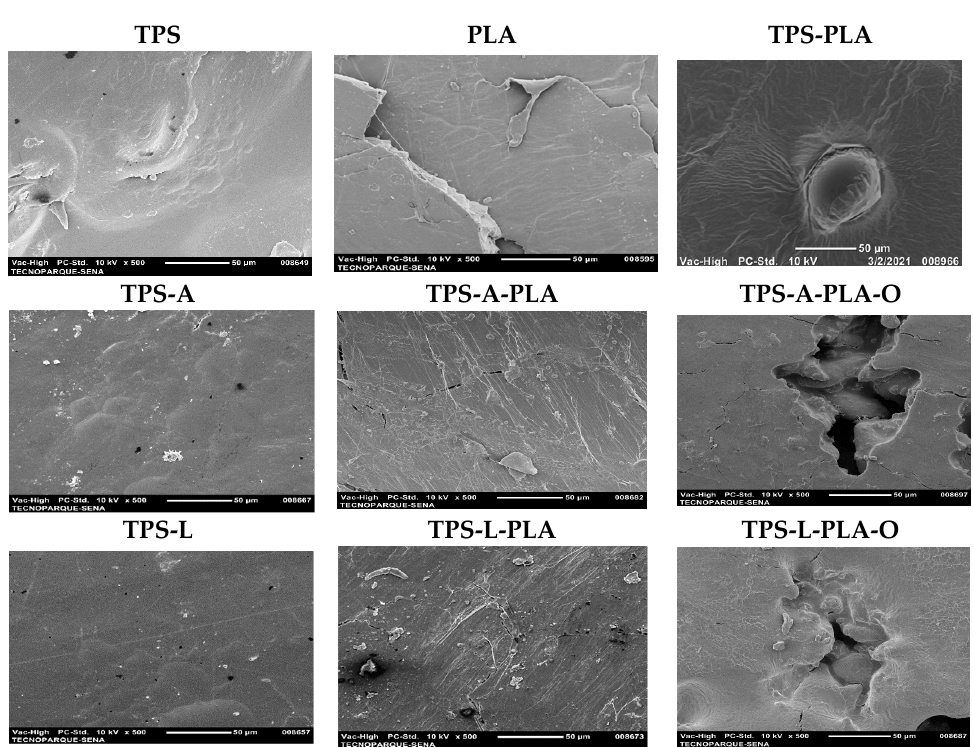
Figure 7. Micrographs obtained by scanning electron microscopy (SEM) with magnifications of 500X for blends of TPS and TPS/PLA.